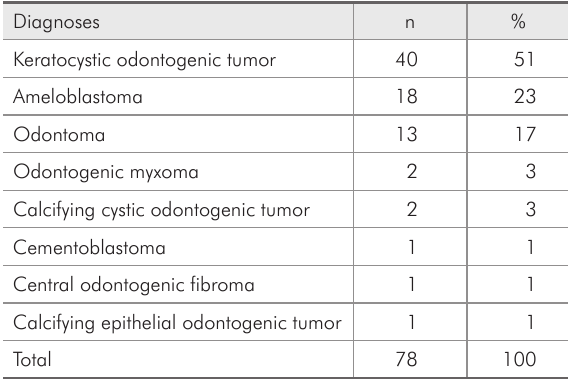
Table 1 - Distribution of the cases diagnosed.